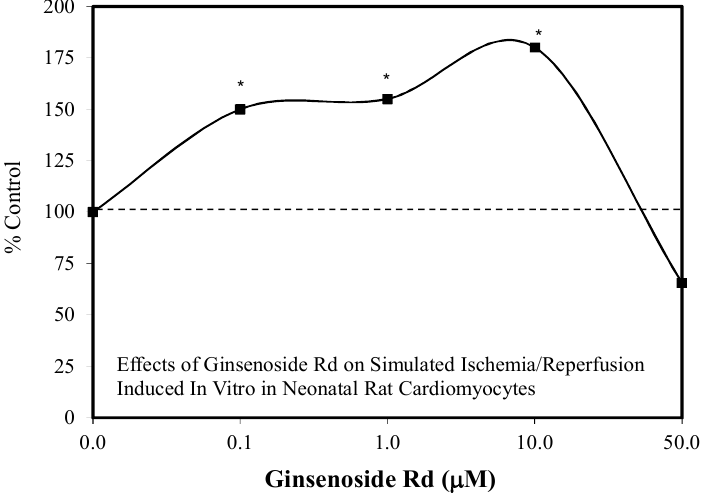
Figure 30. E ff ects of ginsenoside Rd on simulated ischemia / reperfusion induced in vitro in neonatal rat cardiomyocytes (source: [109]). Each * represent statistical significance for a data point.